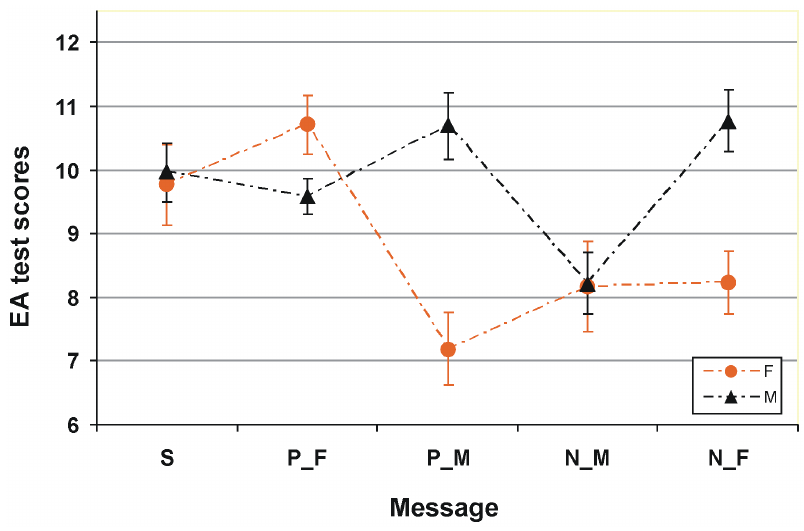
Fig. 2. Gender stereotype susceptibility. Scores on the event arrangement (EA) test for female (represented by orange circles) and male (represented by black triangles) participants in the groups with different information given prior to testing: S, standard instruction, gender neutral message (data pooled together from control groups of the present study and [39]); P_M, positive for males, ‘‘Males are usually better on this task’’ – an explicit positive gender stereotype message for males (data from [39]), P_F, positive for females: ‘‘Females are usually better on this task’’ – an explicit positive gender stereotype message for females (data from [39]); N_M, negative for males, ‘‘Males are usually worse on this task’’ – an explicit negative gender stereotype message for males, and N_F, negative for females: ‘‘Females are usually worse on this task’’ – an explicit negative gender stereotype message for females. Vertical bars represent ¡